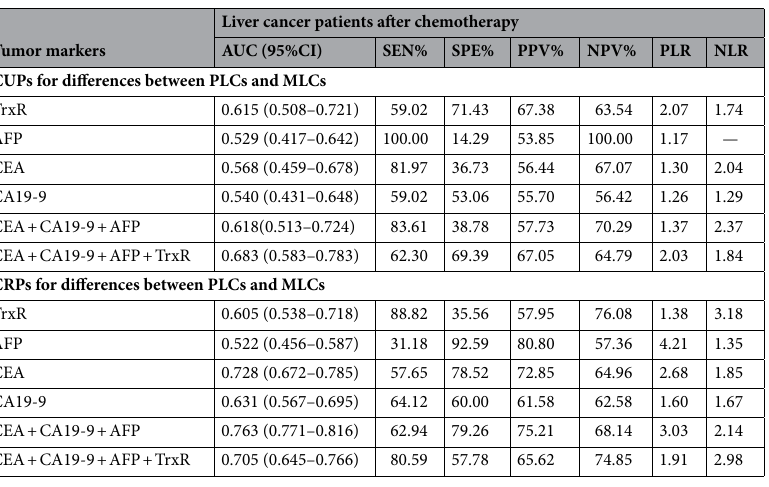
Table 4. Assessment of therapuetic efficiency by TrxR, CEA, AFP, and CA19-9 and their combinations in distinguishing MLC from PLC patients in the CUP and CRP group. SPE: specificity; SEN: sensitivity; NPV: negative predictive value; PPV: positive predictive value;NLR: negative likelihood ratio. PLR: positive likelihood